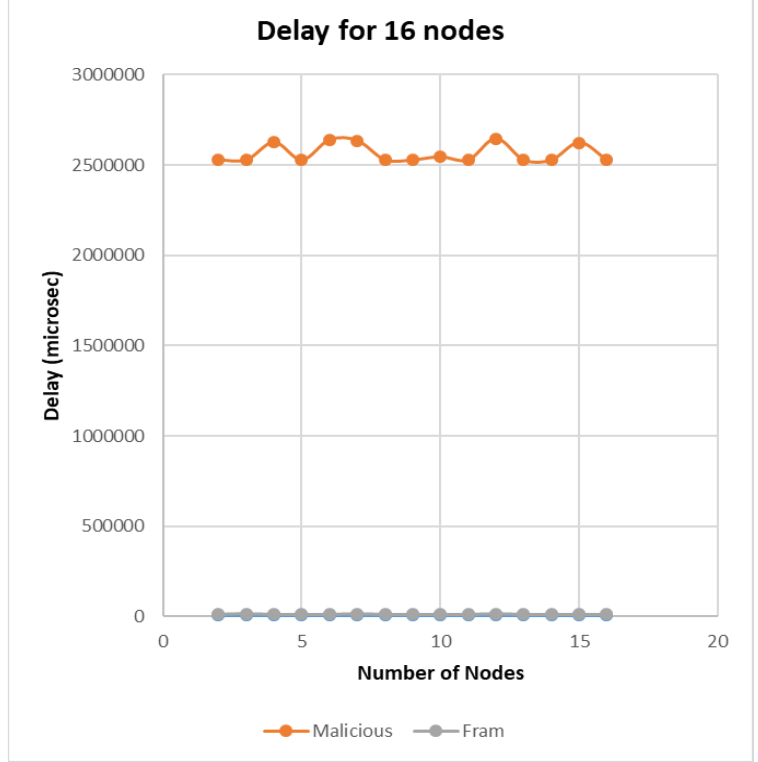
Figure 11. Delay for 16